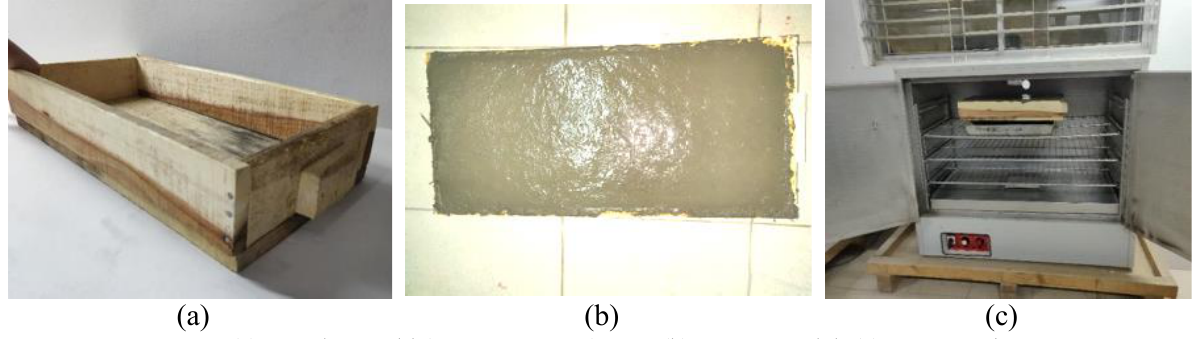
Fig. 4. (a) Wooden Mold (500 × 250 × 75) mm, (b) Concrete Slab (c) Oven